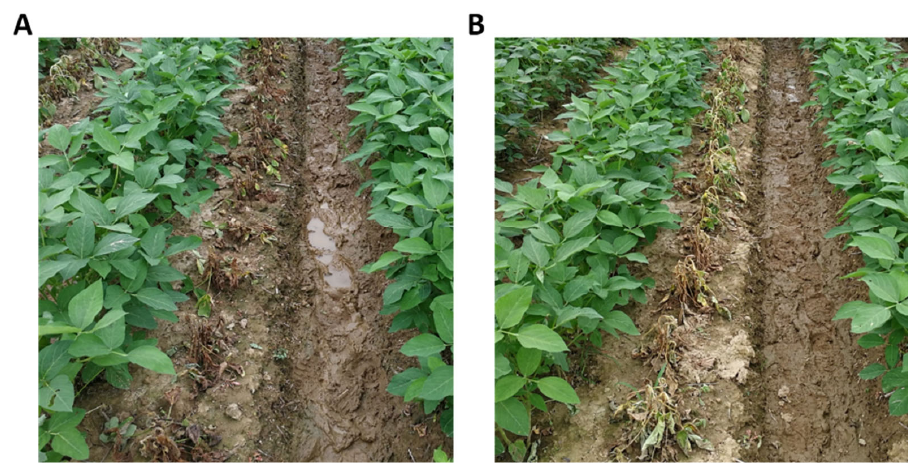
Figure 4. Field assays of herbicide tolerance for the transgenic soybean expressing P450 ‐ N ‐ Z1. ( A ) Spray of flazasulfuron at 300 g a.i./ha; ( B ) spray of 2,4 ‐ D at 1440 g a.i./ha. Transgenic and non ‐ transgenic soybean were planted and sprayed in twin rows.